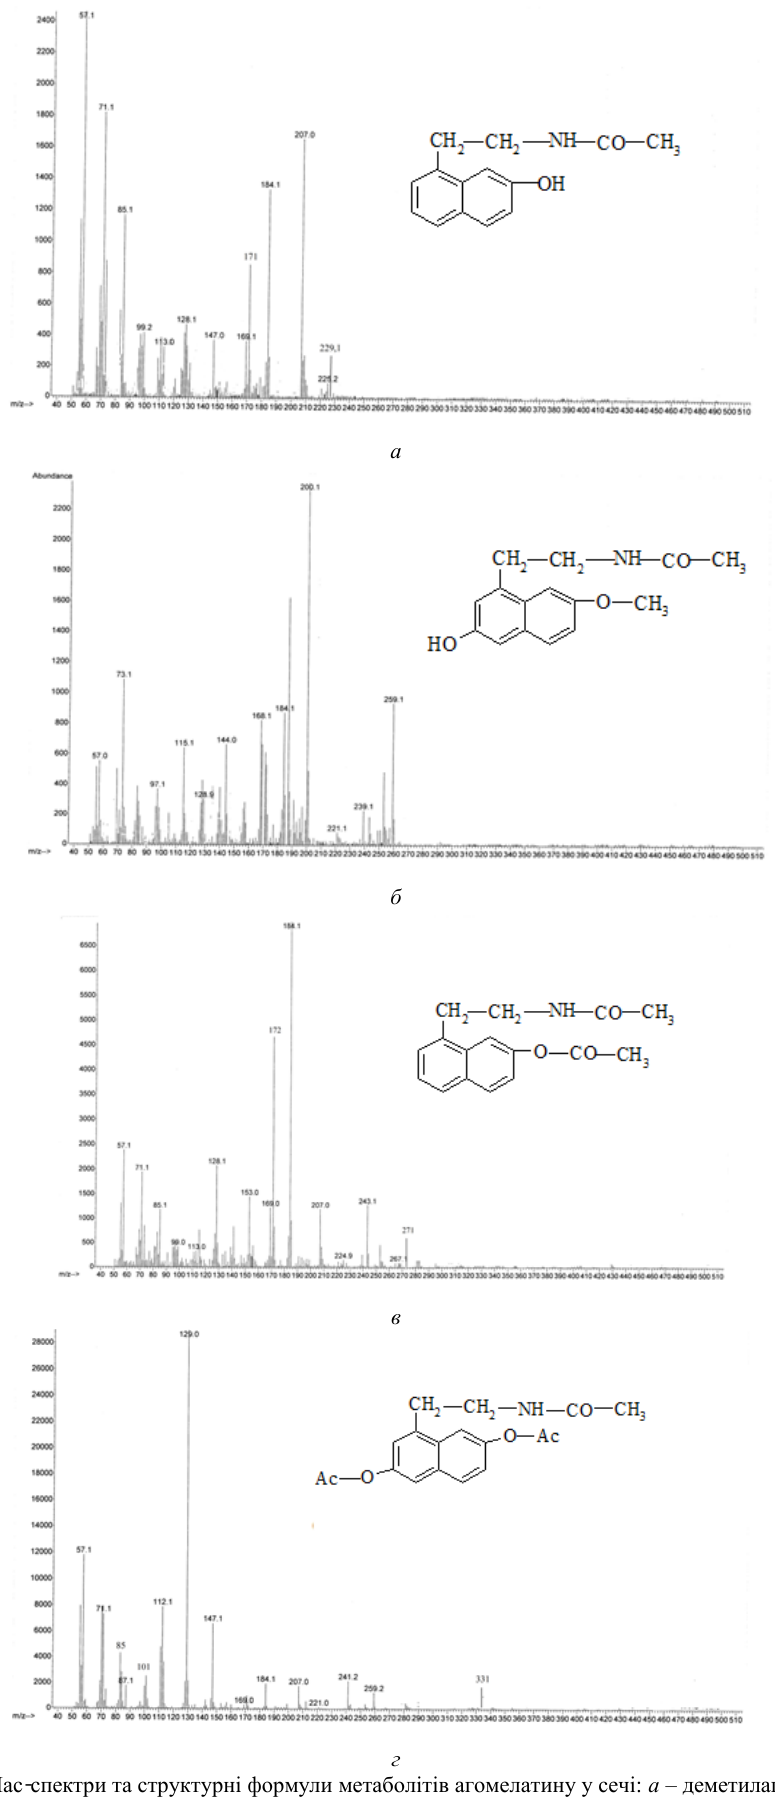
Рис. 5. Мас-спектри та структурні формули метаболітів агомелатину у сечі: а –